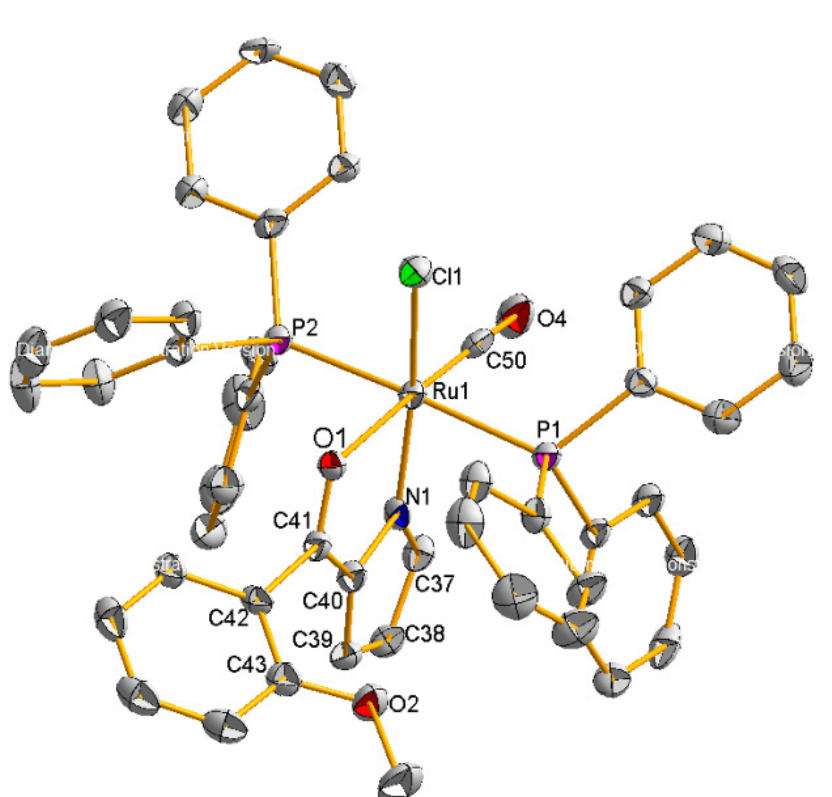
Figure 2. The molecular geometry of Compound 3 . The thermal ellipsoids were drawn at 50% probability and all the hydrogen atoms were omitted for clarity.